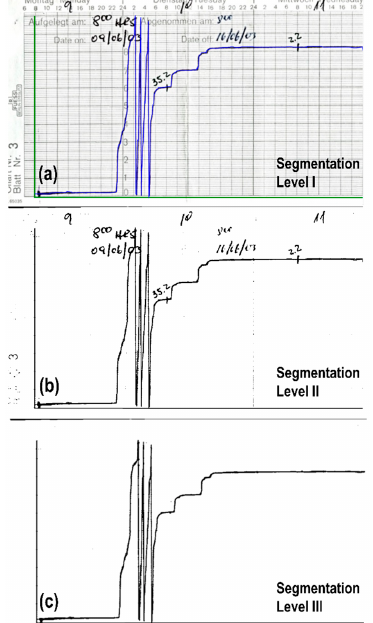
Figure 7. The segmentation process: ( a ) original image from PSC; ( b ) and ( c ) segmented image for two different levels of segmentation.